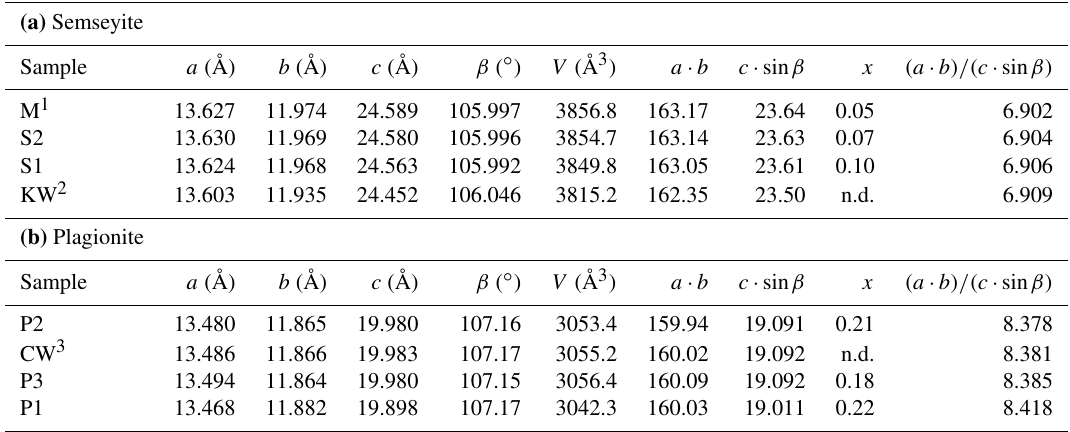
Table 6. Relationships between unit-cell geometry and Pb / Sb crossed-substitution coefficient x in plagionite and semseyite. Samples classi- fied according to increasing (a · b)/(c · sin β)